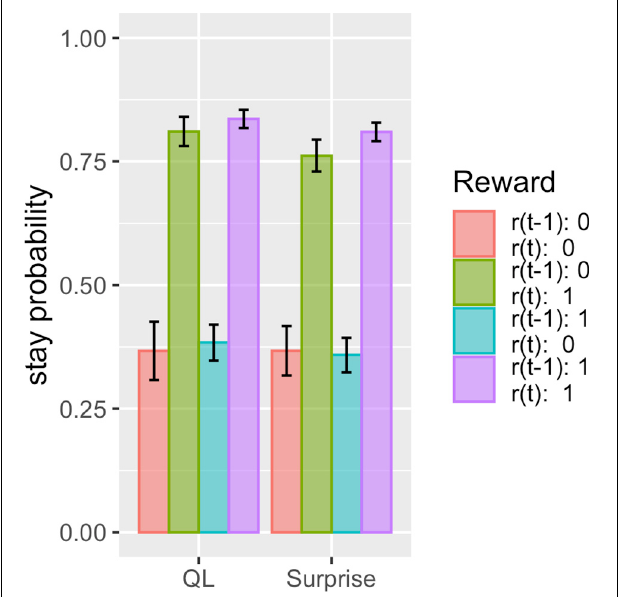
FIGURE 4 | Effect of reward history on stay probability of the Q-learning model and surprise-sensitive utility model. Data are presented as the mean ± standard error. We found a smaller stay probability in proximate reward conditions [ r ( t ) = 1], especially in the surprised reward condition [ r ( t ) = 1, r ( t − 1) = 0], in the surprise-sensitive utility model compared with the Q-learning model. QL, Q-learning model; surprise, surprise-sensitive utility